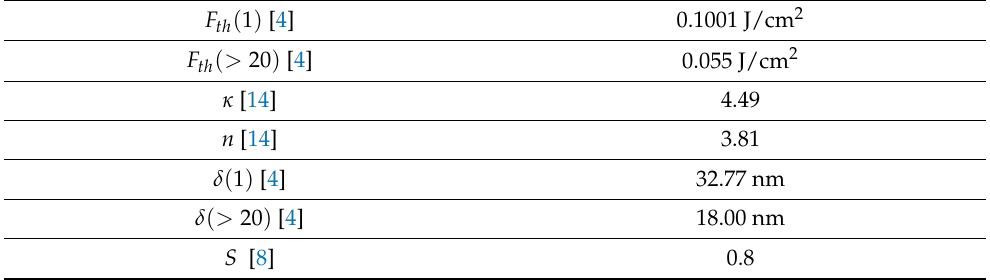
Table 2. Material parameters for stainless